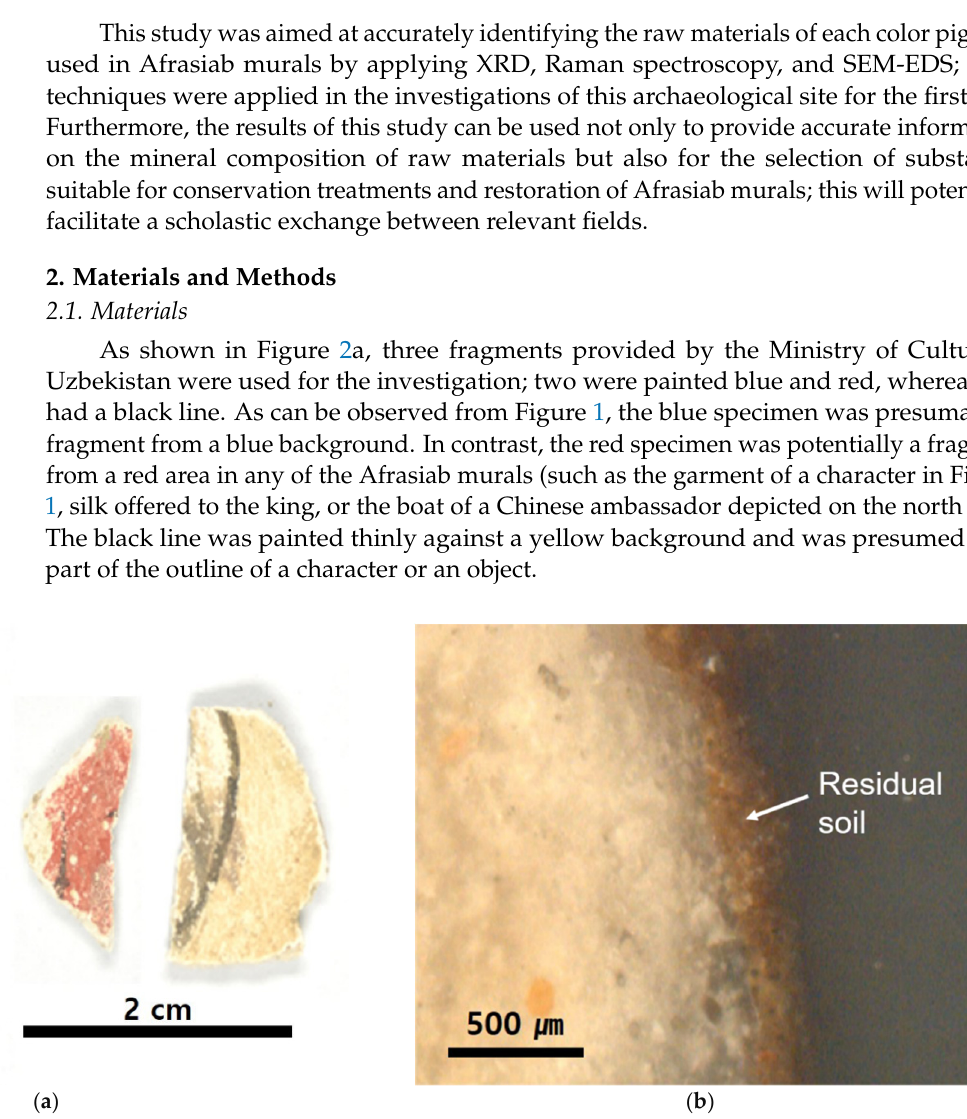
Figure 2. ( a ) Sample fragments for blue, red, and black pigments; ( b ) residual soil under the red sample. After surface inspection, a small amount of powder was collected from each